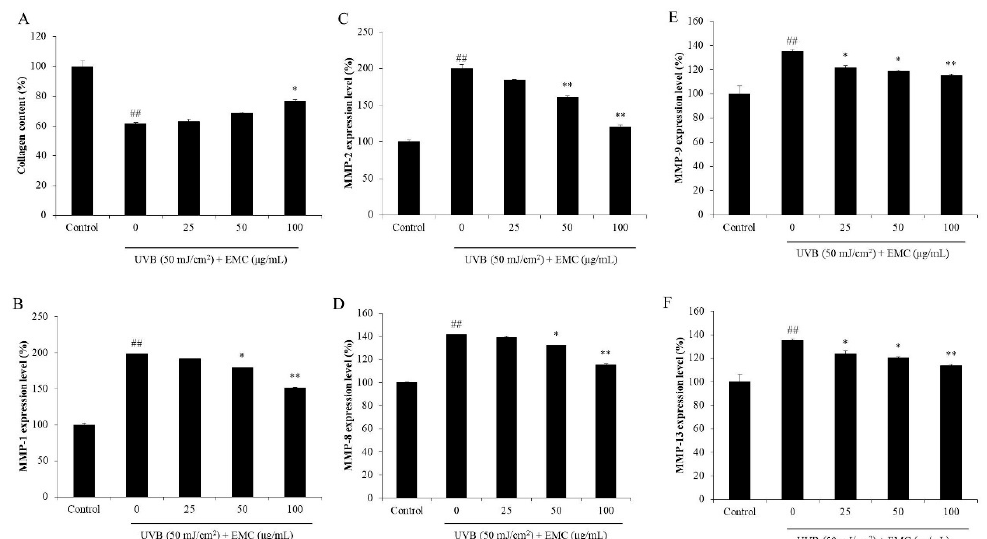
Figure 7. EMC improves collagen content and inhibits the expression of MMPs in UVB-irradiated HDF cells. ( A ) Collagen contents in UVB-irradiated HDF cells; ( B ) MMP-1 expression levels; ( C ) MMP-2 expression levels; ( D ) MMP-8 expression levels; ( E ) MMP-9 expression levels; ( F ) MMP-13